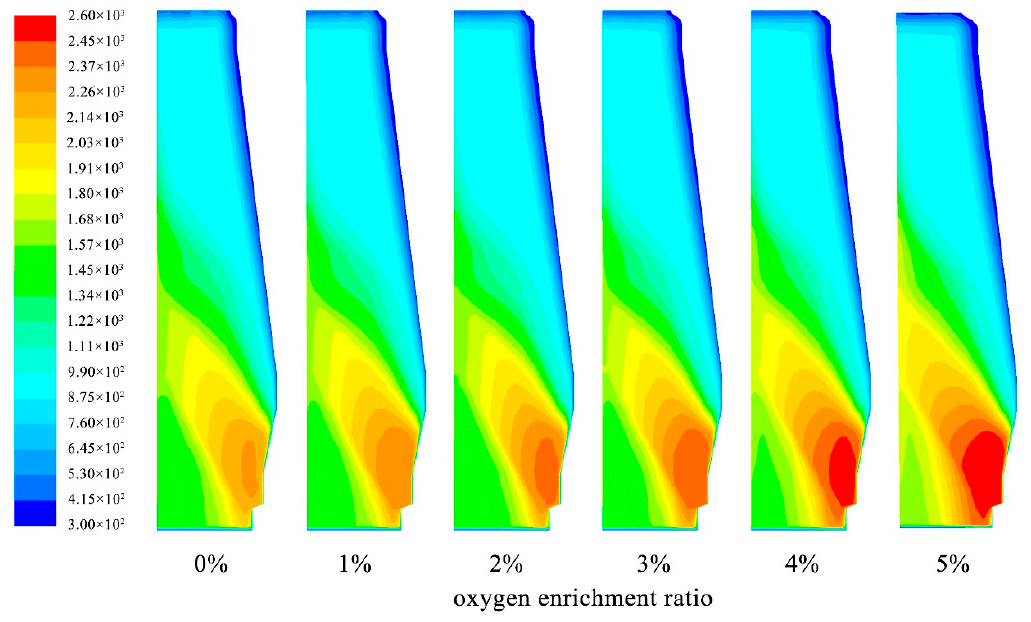
Figure 4. Temperature profiles at different oxygen enrichment ratios.